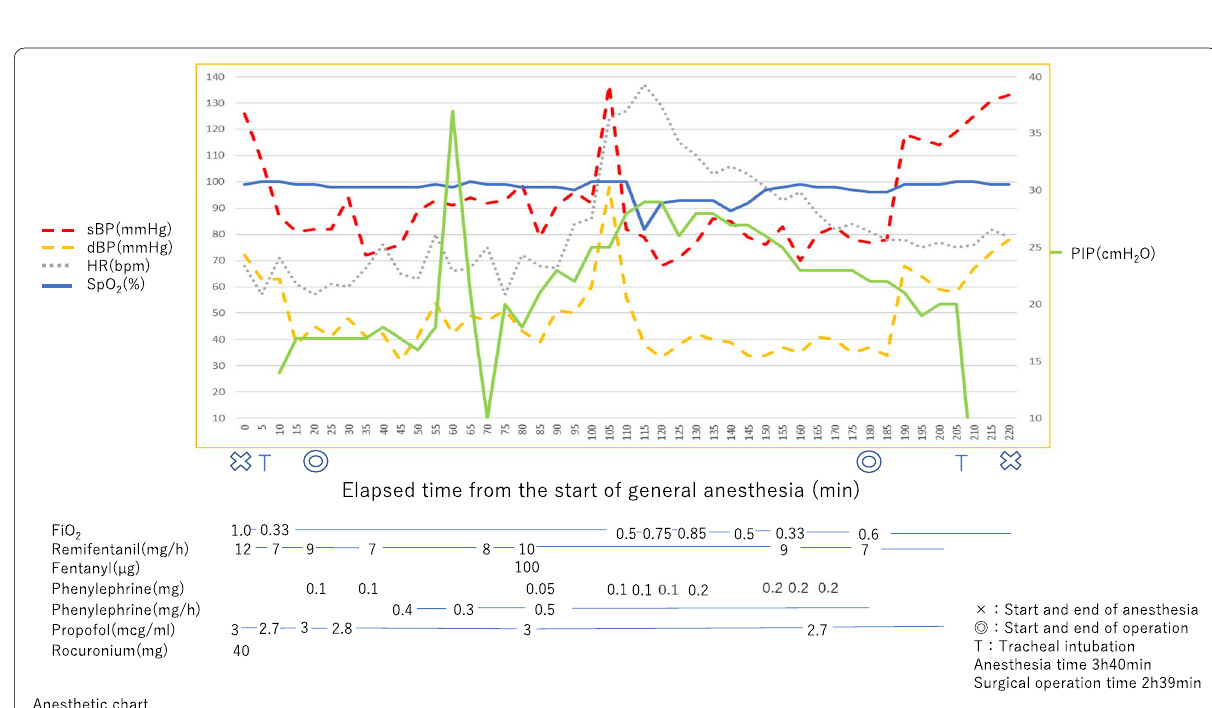
Fig. 2 Anesthesia chart. sBP, systolic blood pressure; dBP, diastolic blood pressure; HR, heart rate; SpO2, saturation of percutaneous oxygen; PIP,